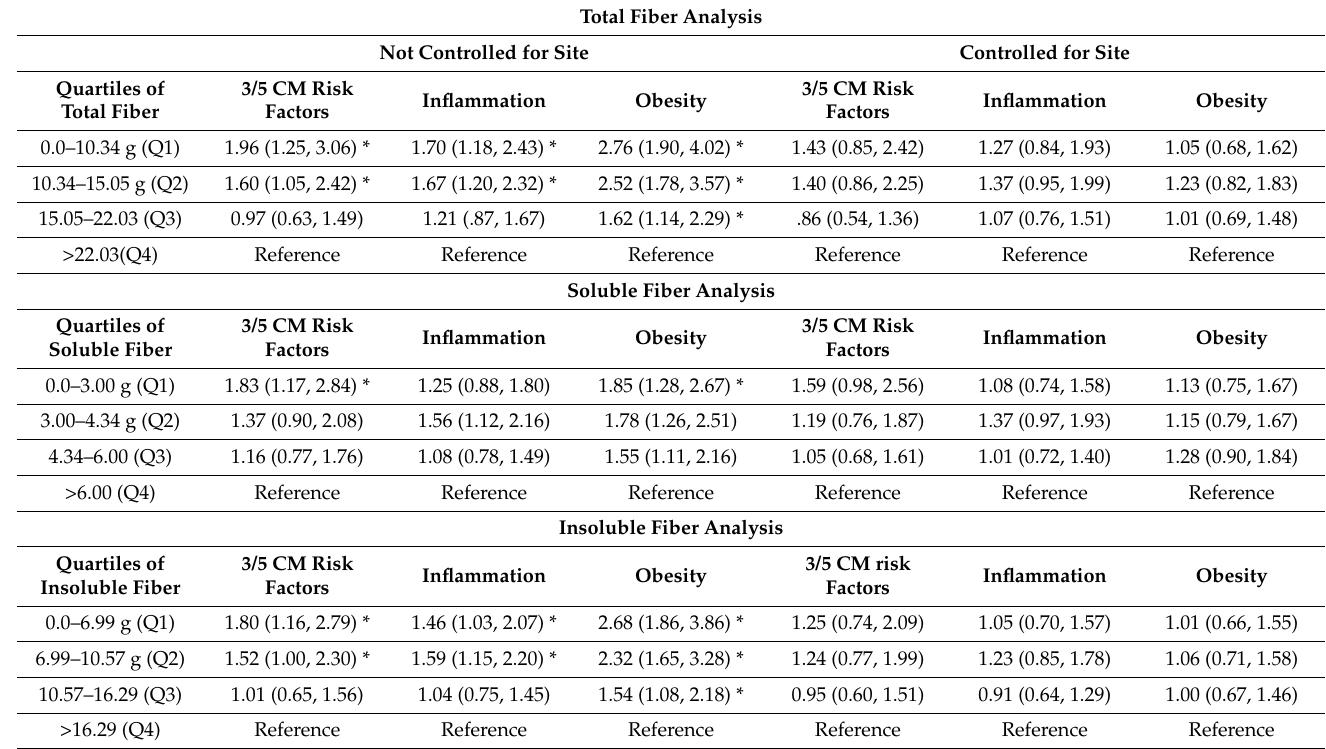
Table 3. Adjusted odds ratios for cardiometabolic risk based on quartiles of total fiber, soluble fiber, and insoluble fiber intake in four countries across the epidemiological